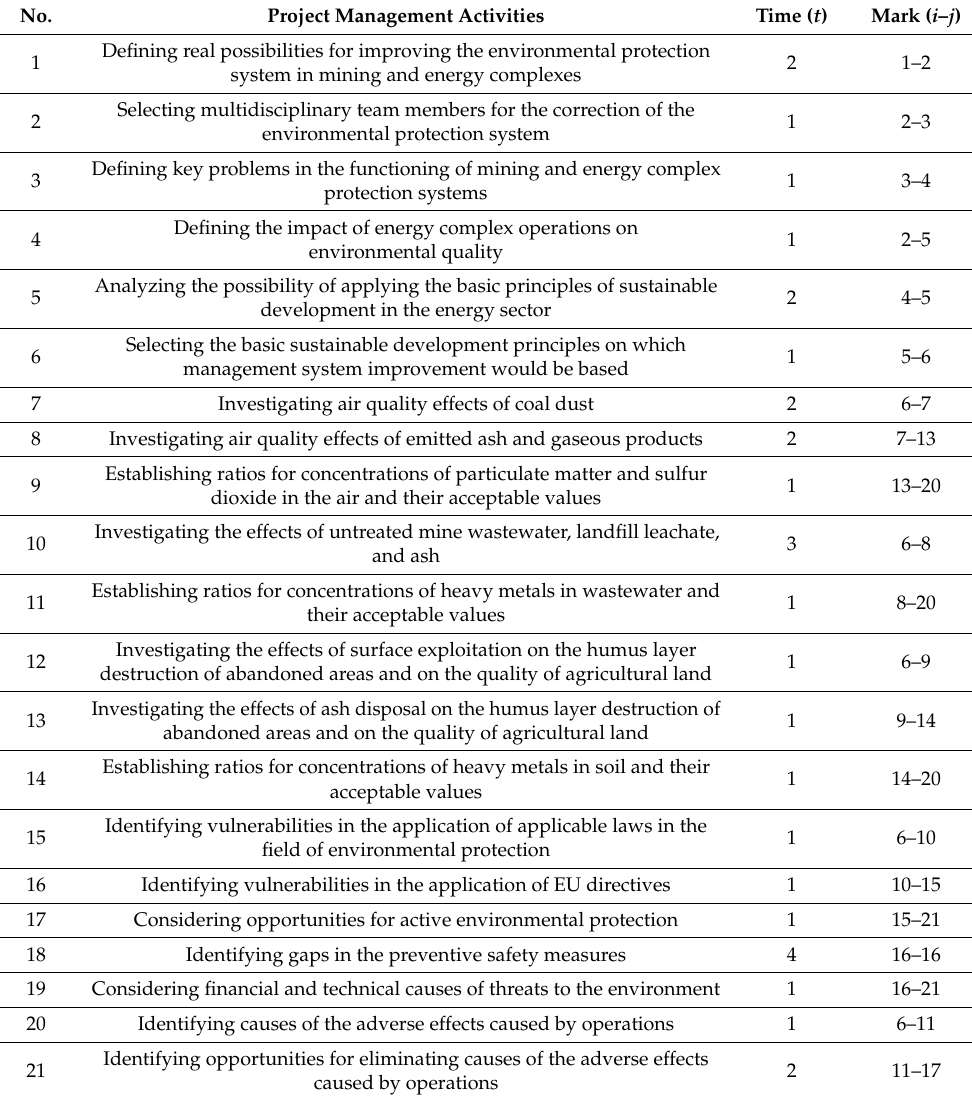
Table 5. A list of project management activities with the defined duration and schedule of